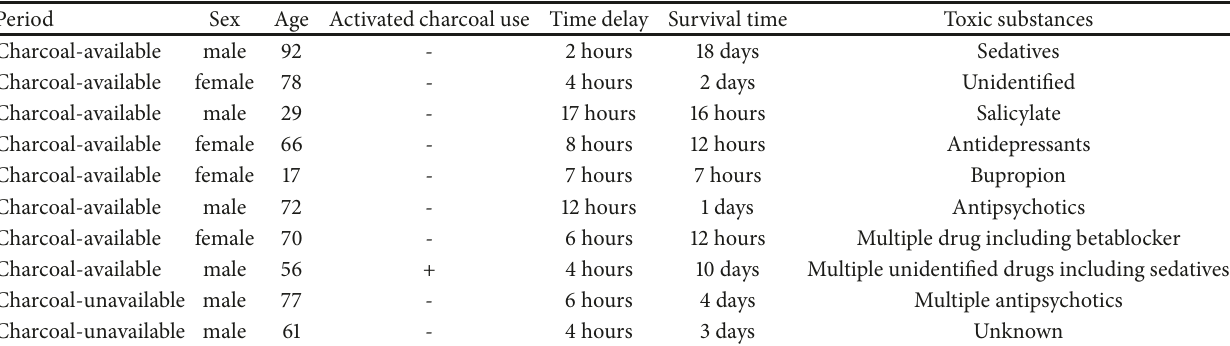
Table 8: Summary of mortality